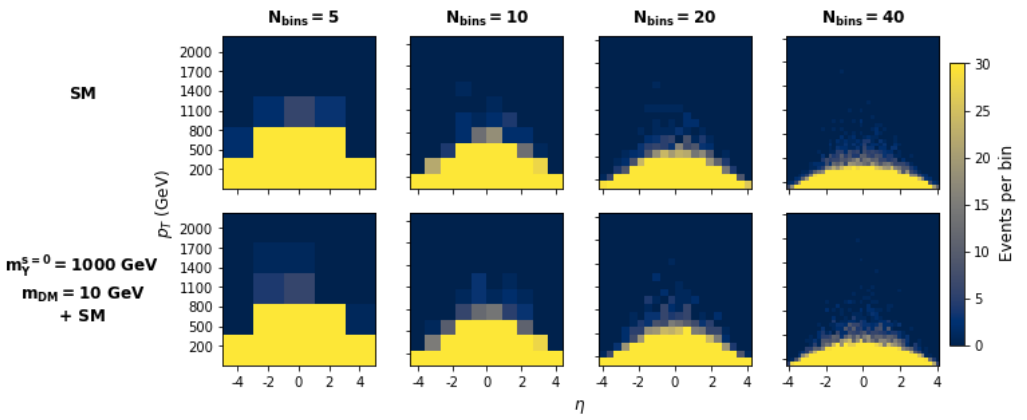
Figure 27: 2D histograms with different number of bins for the monojet final state considering SM and a spin-0 mediator model. Each figure was constructed with (cid:112) B = 50k SM events and S / B = 2.23 new physics events, at detector level. The color coding represents the number of events per bin, however the color scheme saturates at 30 events, to ease visualization.